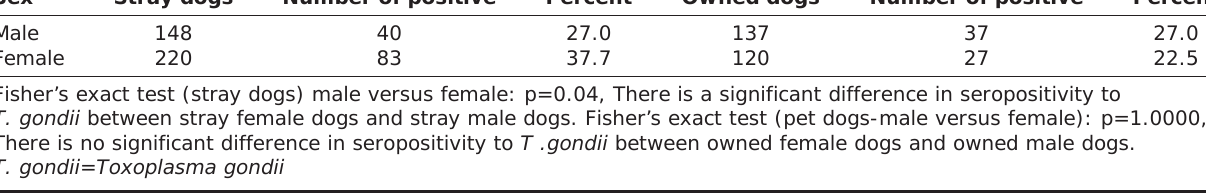
Table-2: Seroprevalence of T. gondii in stray and owned dogs according to gender Sex